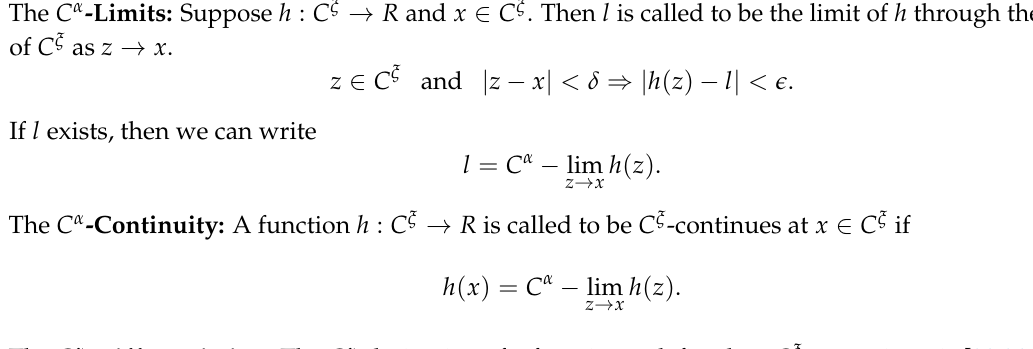
This value leads to the β -dimension since it shows convergence to the finite valve while δ → 0, which can be seen by choosing different various pairs of ( δ 1 , δ 2 )